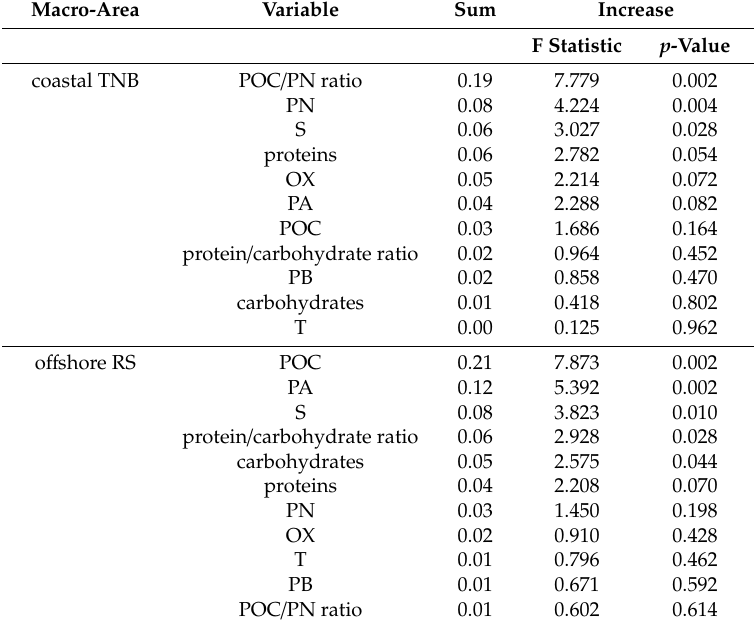
Table 6. RDA results: conditional e ff ects for the two macro-area data. Sum: increase total sum of eigenvalues after including new variable. Increase: increase in explained variation due to adding an extra explanatory